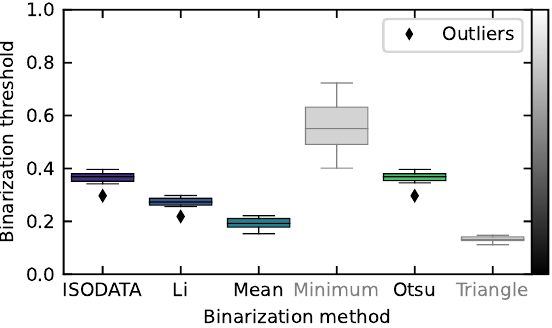
Figure 10. Box plot of binarization thresholds for images of test data set, as calculated by ISO- DATA [38], Li’s [39], mean thresholding, minimum [40], Otsu’s [41] and triangle [42] method, respec-